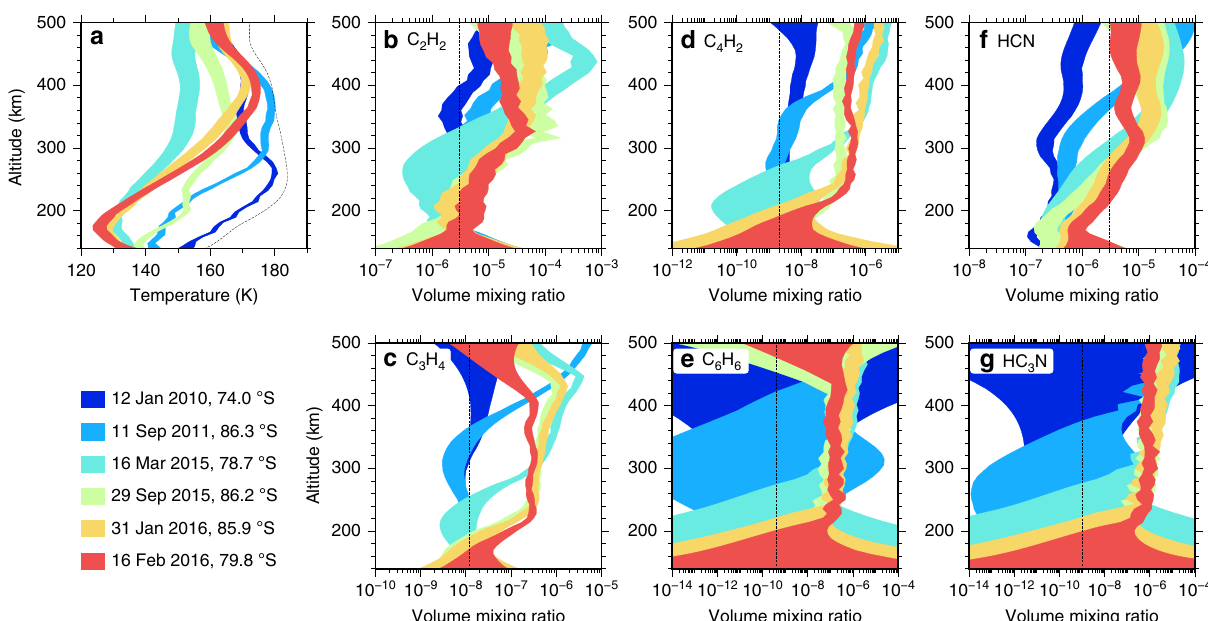
Fig. 4 Evolution of south polar vortex temperature and trace gas abundance. Altitude pro fi les were determined from Cassini CIRS 0.5 cm − 1 spectral resolution limb integration observations at 80°S. a Middle-stratosphere and lower-stratosphere (100 – 250 km) temperatures generally exhibit a steady decrease until 2015, at which point the temperatures stabilise. Mesospheric temperatures at 400 km exhibit an early heating to 180 K, followed by a cooling of ≥ 25 K which persists until 2015, before heating up again to around 170 K in 2016. b – g Trace gas pro fi les are advected downwards during this period, leading to extreme enrichments of up to two orders of magnitude as air is brought down from the upper atmosphere photochemical source regions. Vortex composition stabilises around 2015, although there is a subsequent slight decrease in trace gas abundance at high altitude. Pro fi le envelopes indicate 1- σ inversion uncertainties. HC 3 N and C 6 H 6 have very large uncertainties for the earliest observations due to small initial abundances and resulting low signal-to-noise. Thin dotted lines show the temperature and trace gas a-priori pro fi